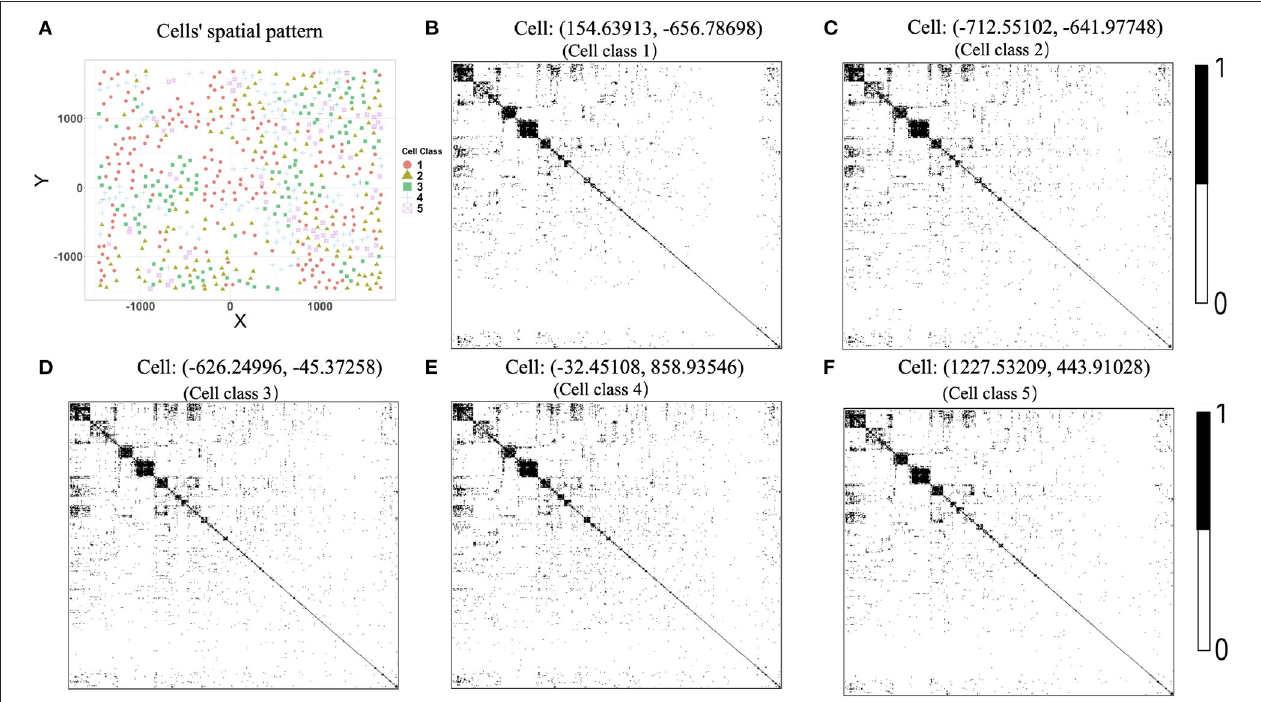
FIGURE 8 | (A) Cells’ spatial distribution pattern, where different colors and shapes of points correspond to different cell classes. (B–F) Estimated gene co-expression networks of five randomly selected cells in the MERFISH U-2 OS cell line data.